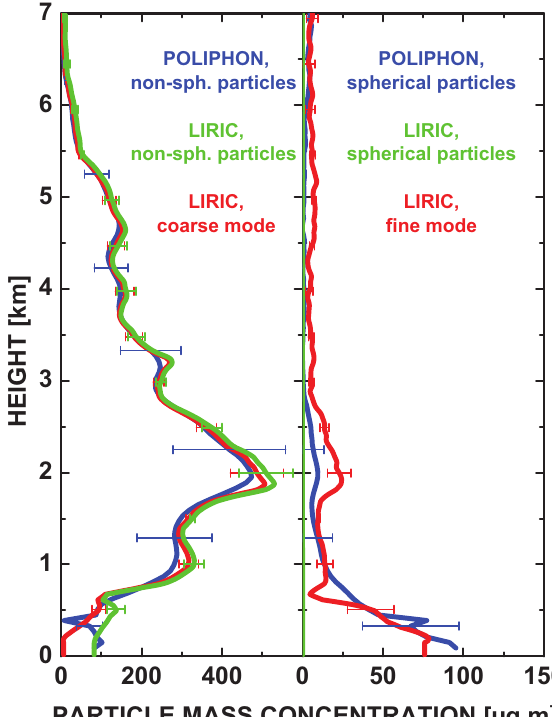
Fig. 6. Particle lidar ratio at 532 nm (blue circles) and particle de- polarization ratio at 532 nm (blue curve) observed on 29 May 2008 with Raman lidar and derived by using the LIRIC profiles in Fig- ure 3 (green curves). Raman lidar signals are smoothed with win- dow lengths of about 1000 m in the case of the lidar ratio (blue symbols). Errors bars indicate the uncertainties (one standard devi- ation). The depolarization ratio profile is given with 60 m resolu- tion. Fig. 5. Comparison of LIRIC- and POLIPHON-derived parti- cle mass concentrations, observed on 29 May 2008. The blue POLIPHON curves are taken from Fig. 2 of Ansmann et al. (2012). Error bars indicate the uncertainties (one standard devia- tion).